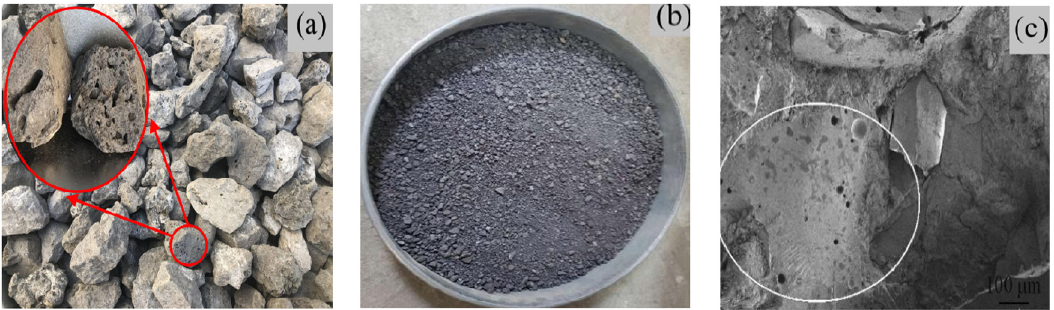
Figure 1: The appearance of SS: ( a ) SS stone; ( b ) SS sand; and ( c ) internal appearance.